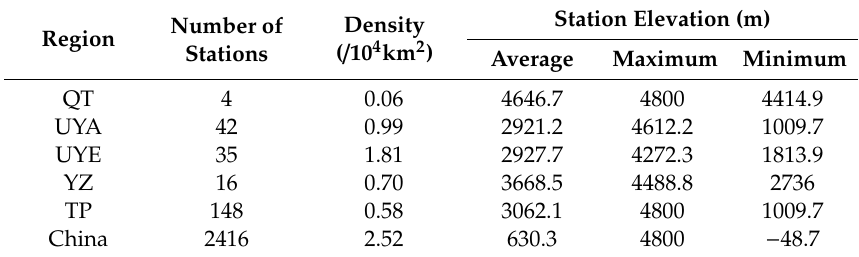
Table 3. Spatial characteristics in meteorological station distribution.